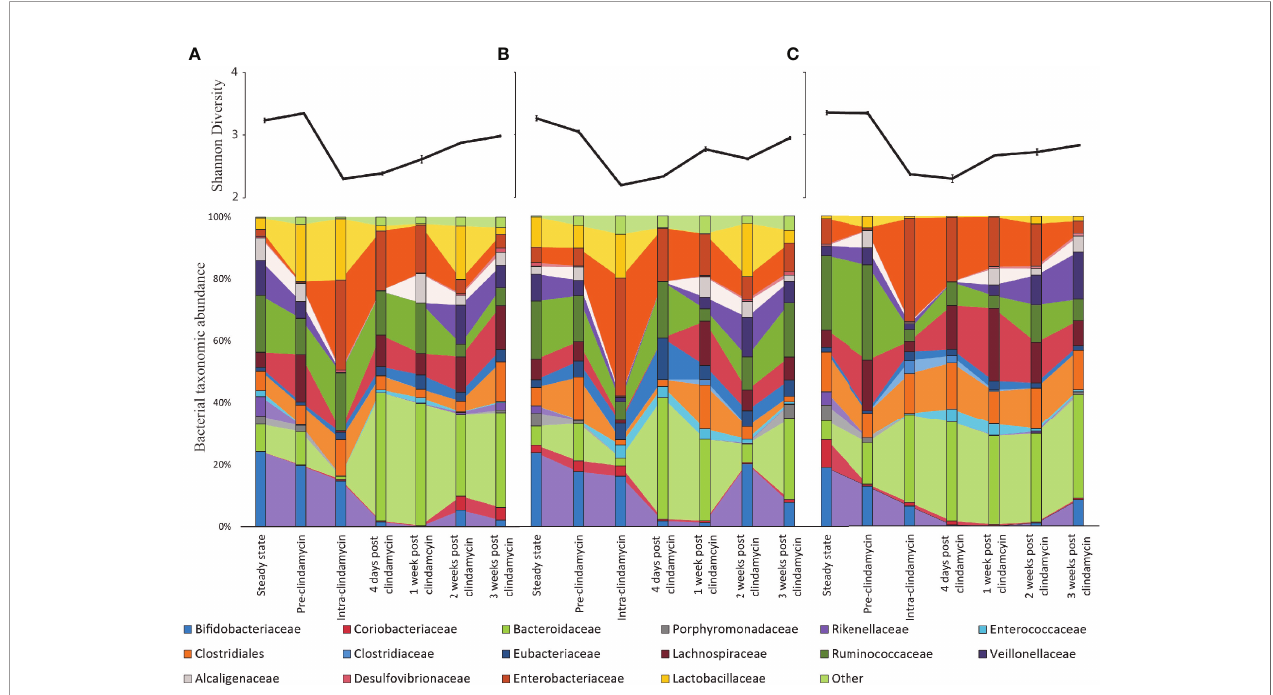
FIGURE 4 | Microbiota changes throughout the model timeline after supplementation with either trehalose (model T; A ), glucose (model G; B ) or saline (model S; C ). Upper line graphs represent diversity changes, as measured by Shannon Diversity Index, throughout the timeline. Results are shown as mean ± S.D of four technical replicates analysed by 16S rRNA sequencing. Lower stacked bar charts represent the bacterial taxonomical abundance changes in each model over time. Results are shown as mean of four technical replicates analysed by 16S rRNA